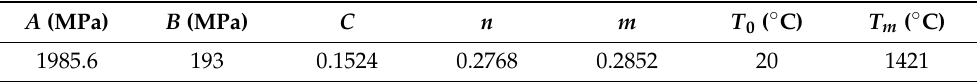
Table 2. The Johnson-Cook model constants for the AISI-D3 steel